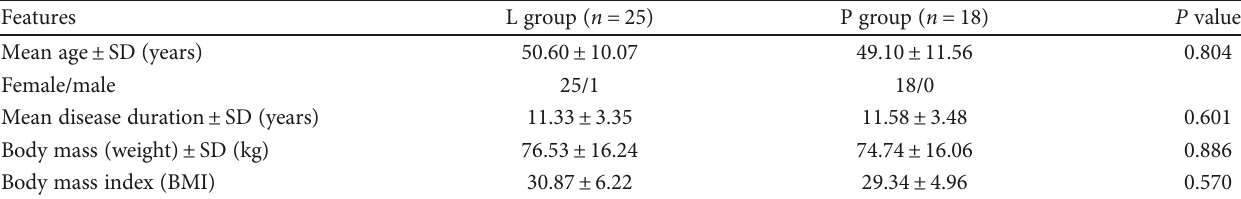
Table 1: Baseline characteristics of the patients included in this study